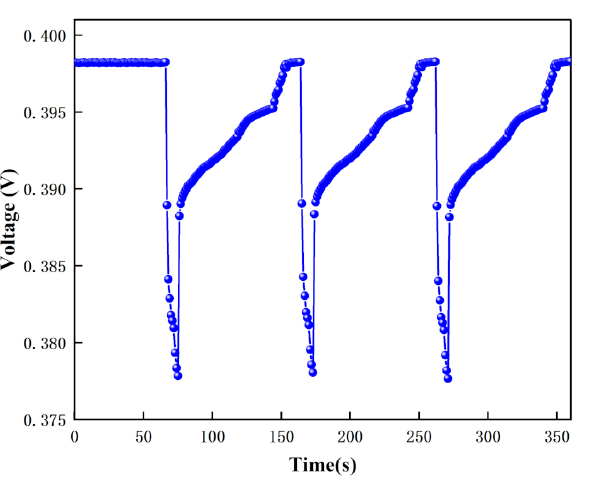
Figure 27. The test results of moisture. The voltage response graph for different purity moisture environments are shown in Figure 28, and the voltage variation graph for different purity moisture environments are shown in Figure 29. In this experiment, the voltage is 0.398 V when there is no moisture, and 0.377 V when moisture (99.999% purity) is introduced. From the calculation, we can get that the gas detected is moisture when the amount of the voltage drop change is 0.021 V.